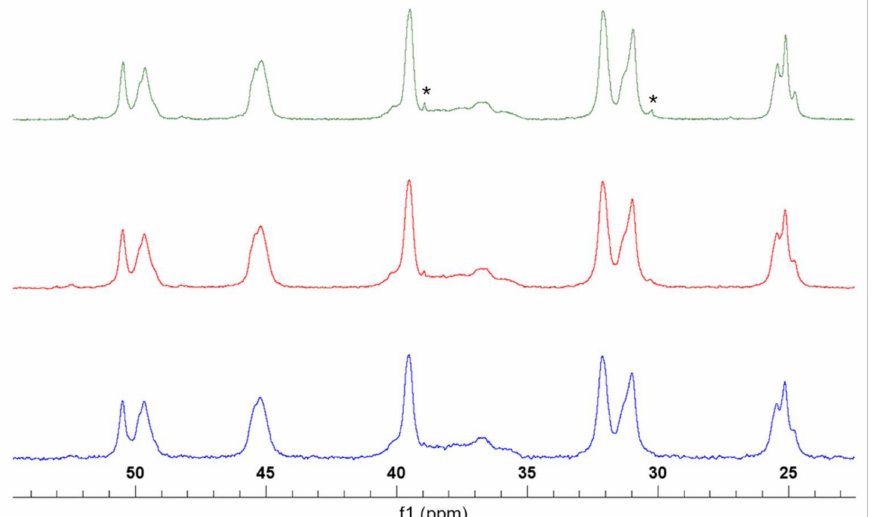
Figure 3. Comparison between 13 C spectra of PNVCL_122 (green), PNVCL_305 (red) and PN- VCL_1220